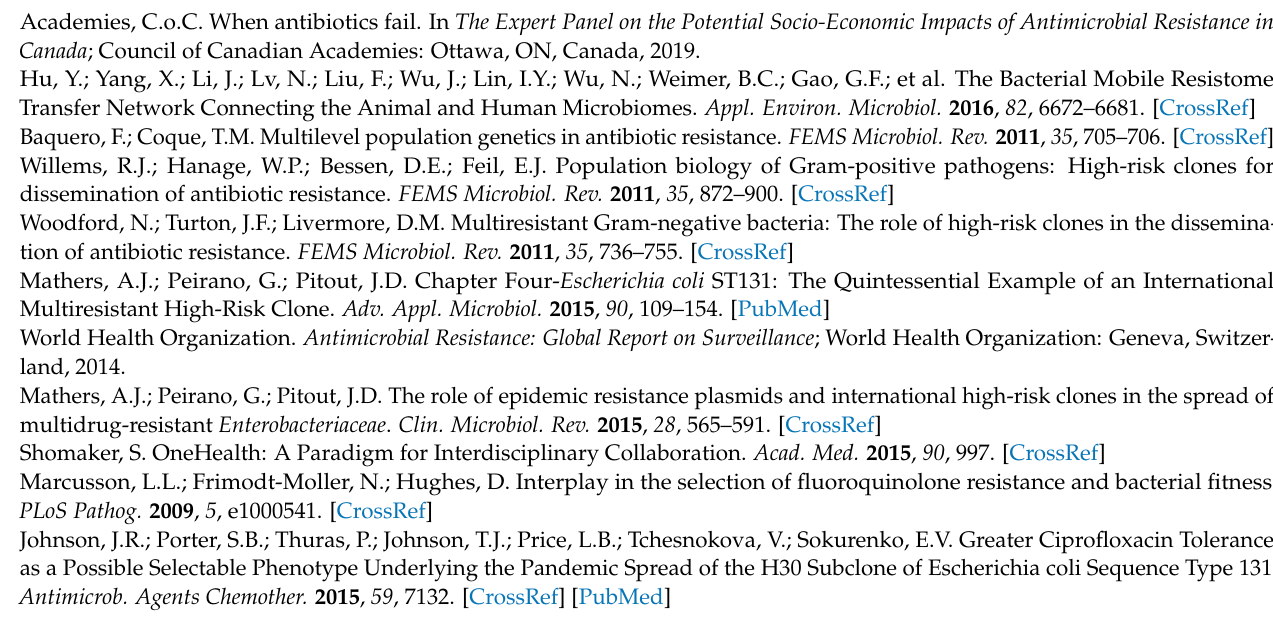
Table S2: Details of the genes absent (highlighted in gray) of present (not highlighted) in the isolates belonging to the clonal lineage A, classified by function. The nomenclature is the same as used in the VFDB database; Table S3: Results from VirulenceFinder database; Table S4: Results from VFDB database; Table S5: Results from ResistanceFinder database; Table S6: from ARG-Annot database; Table S7: Results from PlasmidFinder database; Table S8: Results for the bla genes found both in ResistanceFinder and ARG-Annot databases; Table S9: Number of isolates associated with a disease severity score per clonal lineage. The clonal lineages D, E and F were grouped because the number of isolates for which necropsy reports were available was low; Table S10: Number of isolates associated with a disease severity score per clone within the clonal lineage A; Table S11: Number of isolates associated with each stage of production. The clonal lineage D, E and F were grouped because the number of isolates for each clonal lineage was low; Table S12: Number of isolates associated with each stage of production score per clone within the clonal lineage A; Table S13: Metadata for the 173 isolates used in the first phylogeny analysis; Table S14: Distance Matrix for the second phylogenetic analysis, composed of 192 isolates sampled both in Quebec and in the USA; Raw data sequences are available on GenBank under the bioproject